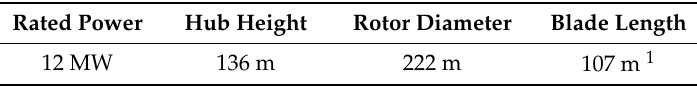
Table 3. Turbine specifications [10].